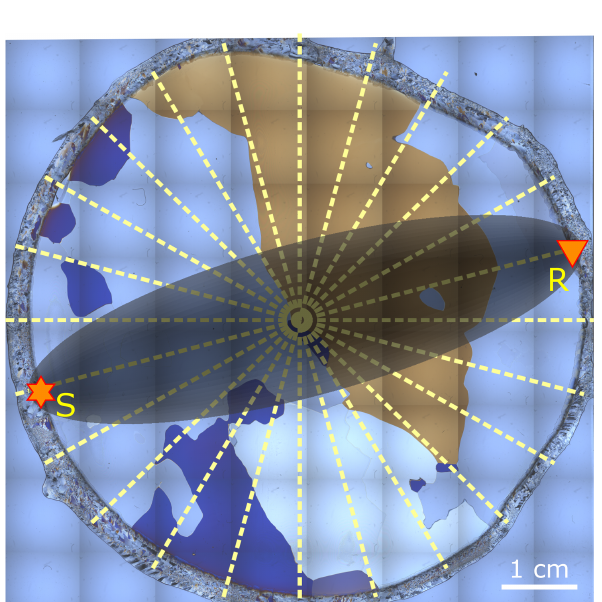
Figure 5. Raw image from fabric analyser, showing a typical grain distribution found in the temperate ice core. The coverage by ul- trasonic measurements (dashed lines) and an example for the first Fresnel zone (homogeneous medium approximation) are superim- posed: S is the sending transducer, and R is the receiver. The dis- tance between source and receivers is ≈ 7cm on average.